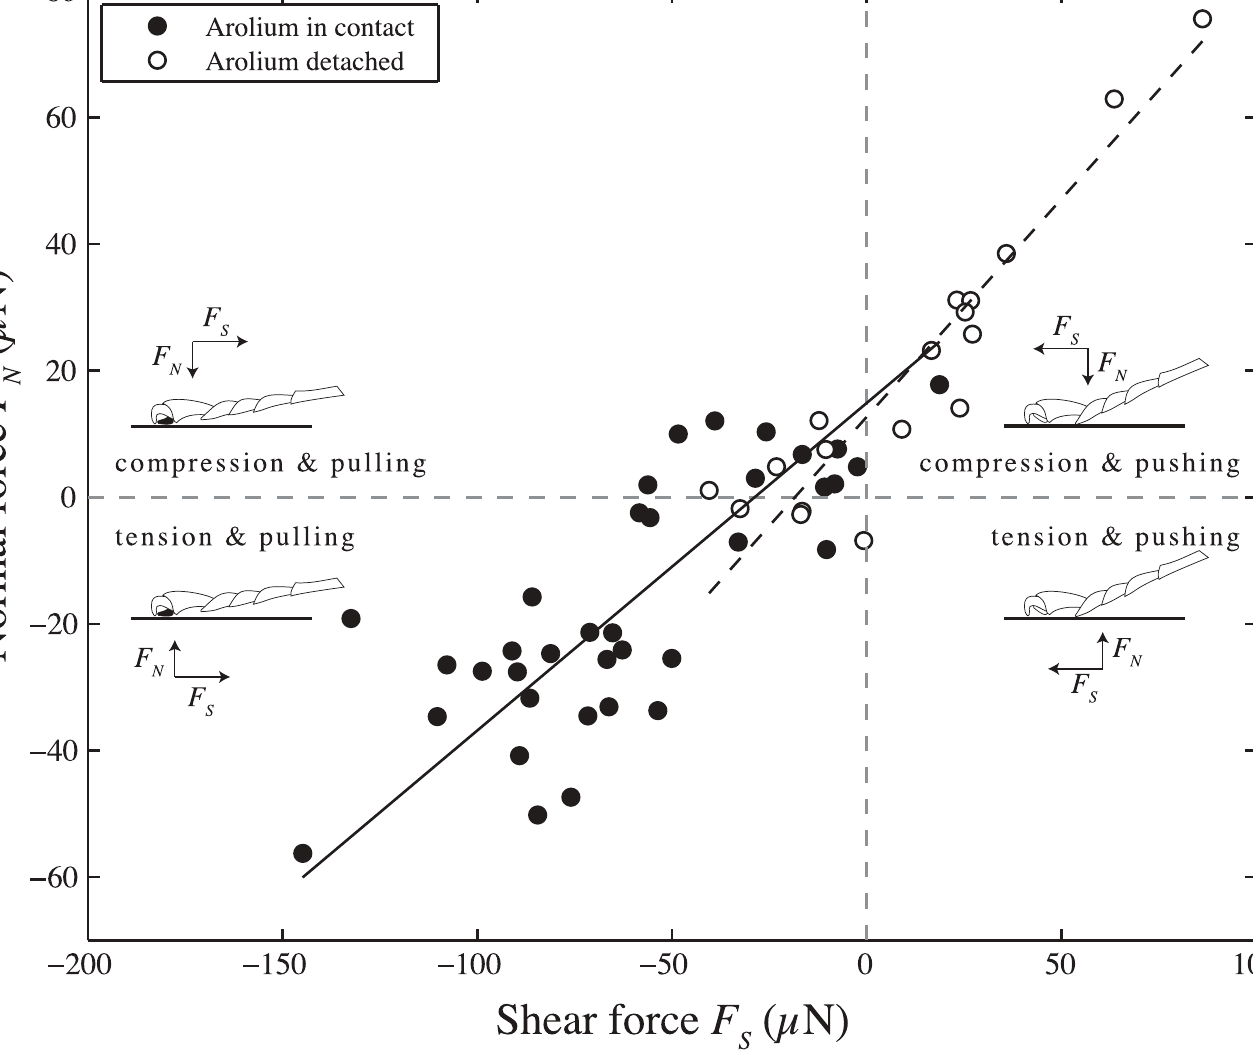
Fig 5. Relationship between peak normal force and corresponding shear force along the (projected) axis of the leg for individual steps. Filled circles denote steps in which the arolium made visible surface contact, whereas steps with detached arolium are marked with open circles. Lines show standardised major axis regressions on both types of steps. In most steps where the adhesive pad made contact, the legs were pulling, whereas steps without visible arolium contact occurred mostly when legs pushed. The drawings illustrate the direction of the normal forces ( F N ) and shear forces ( F S ) and the presence or absence of adhesive pad contact (black or white filling of the